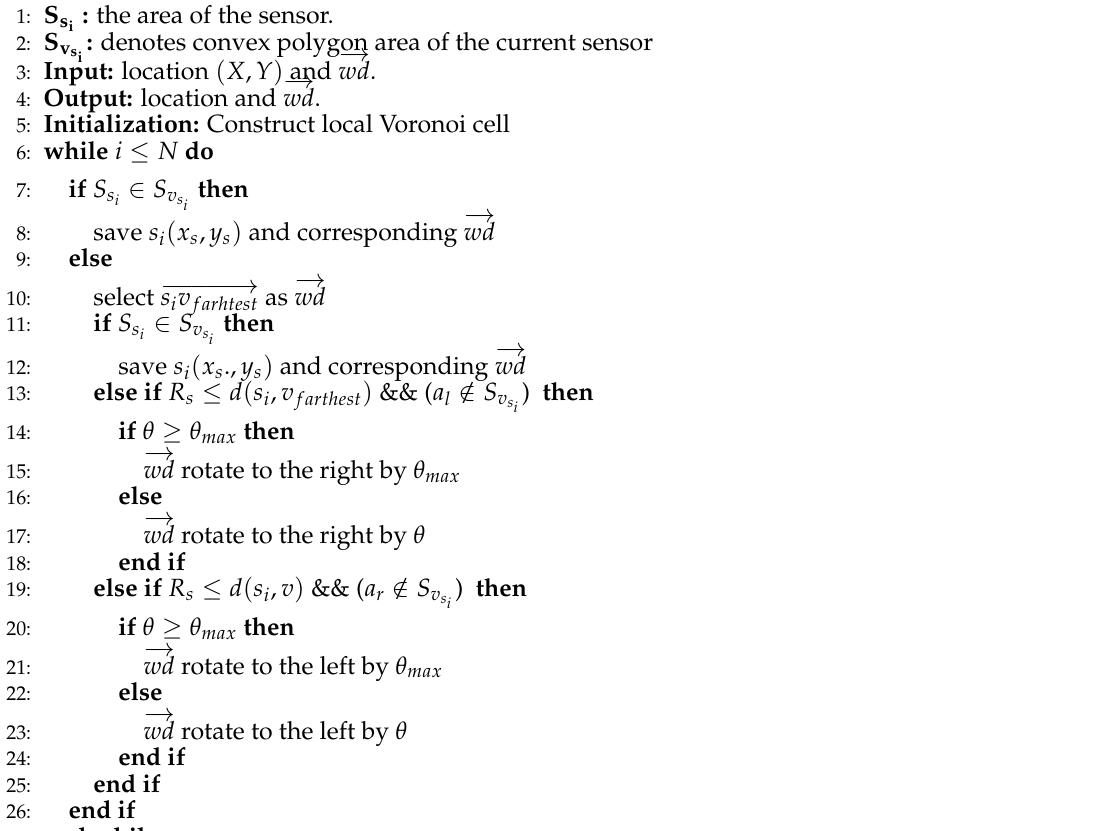
Algorithm 1 Rotate Working Direction Algorithm